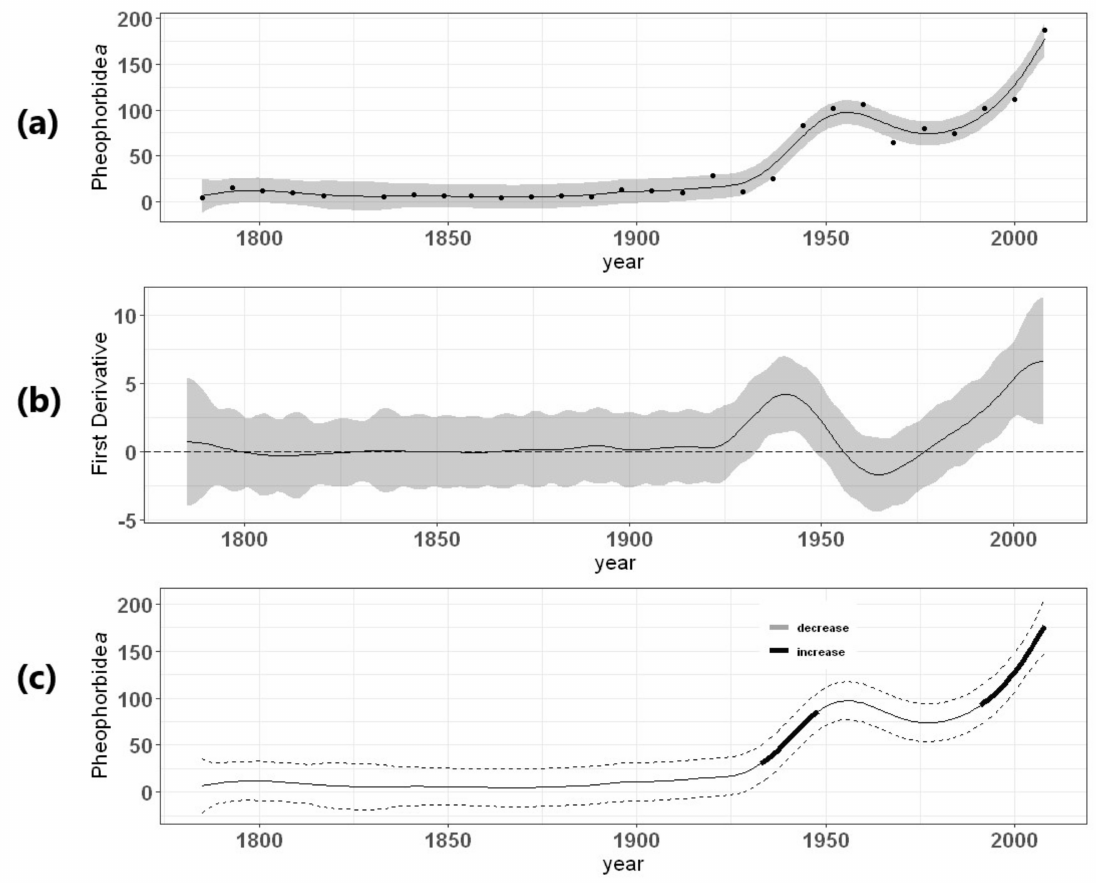
Figure 2. Generalized additive model (GAM) fitted to the time series of pheophorbide a (expressed as η Molesg OM -1 )in the sedimentary archive of Lake Blanca Chica. ( a ) Observed values, GAM-based trend fitted and its simultaneous interval; ( b ) estimated first derivative of the GAM-fitted trend and the 95% simultaneous interval; ( c ) period of